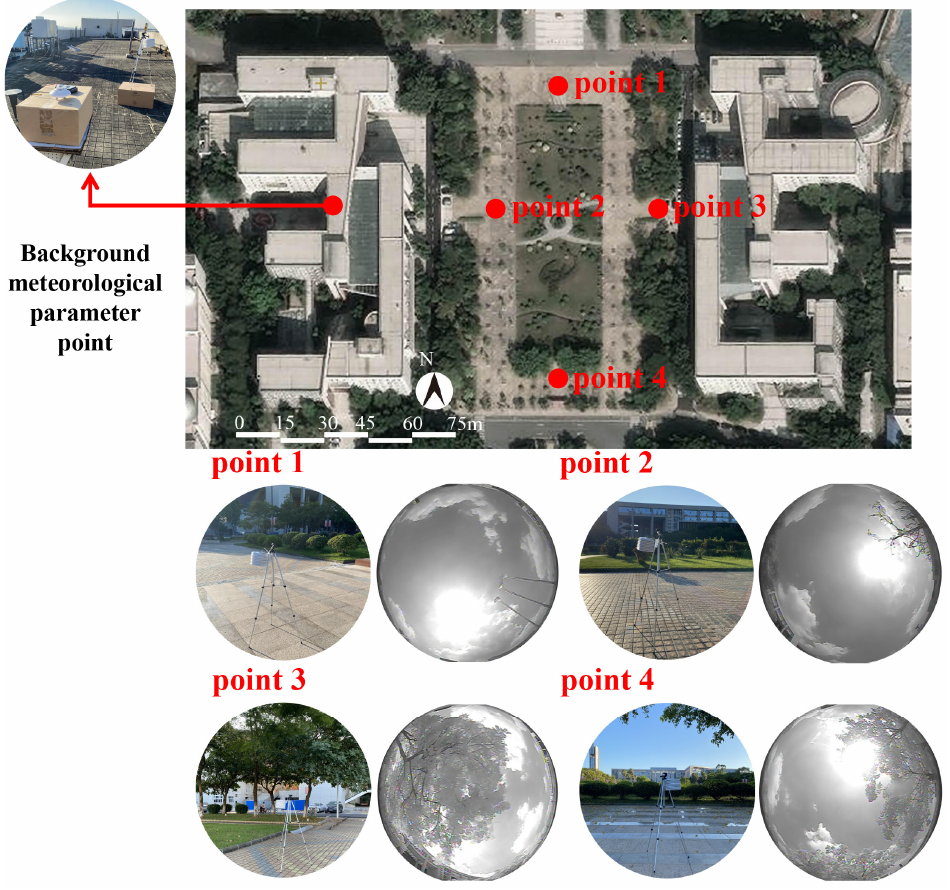
Figure 3. Actual measurement layout .